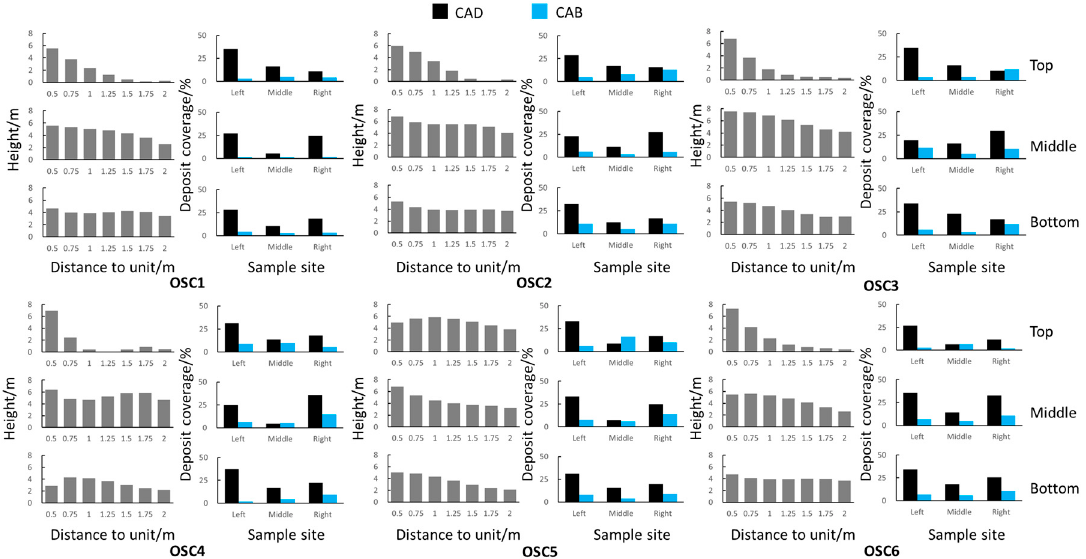
Figure 5. The airflow distribution at different distances from the MAS (left); CAD (black block) and CAB (blue block) of samples in all layers (right) of OSC1–OSC6.